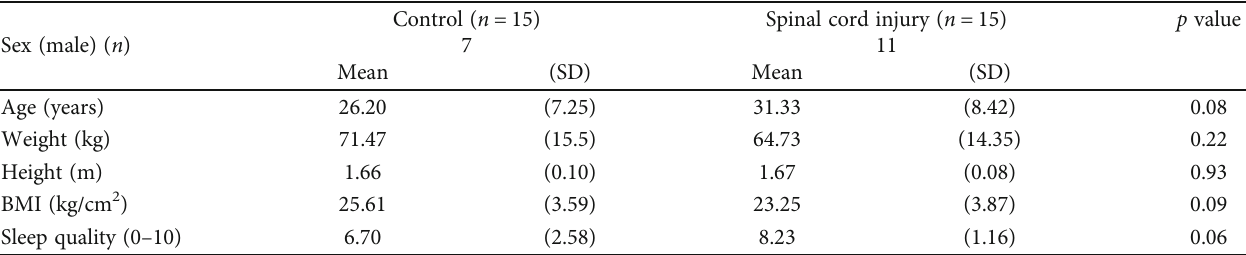
Table 1: Clinical and demographic